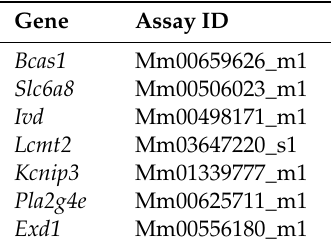
Table 4. Gene expression assays used for